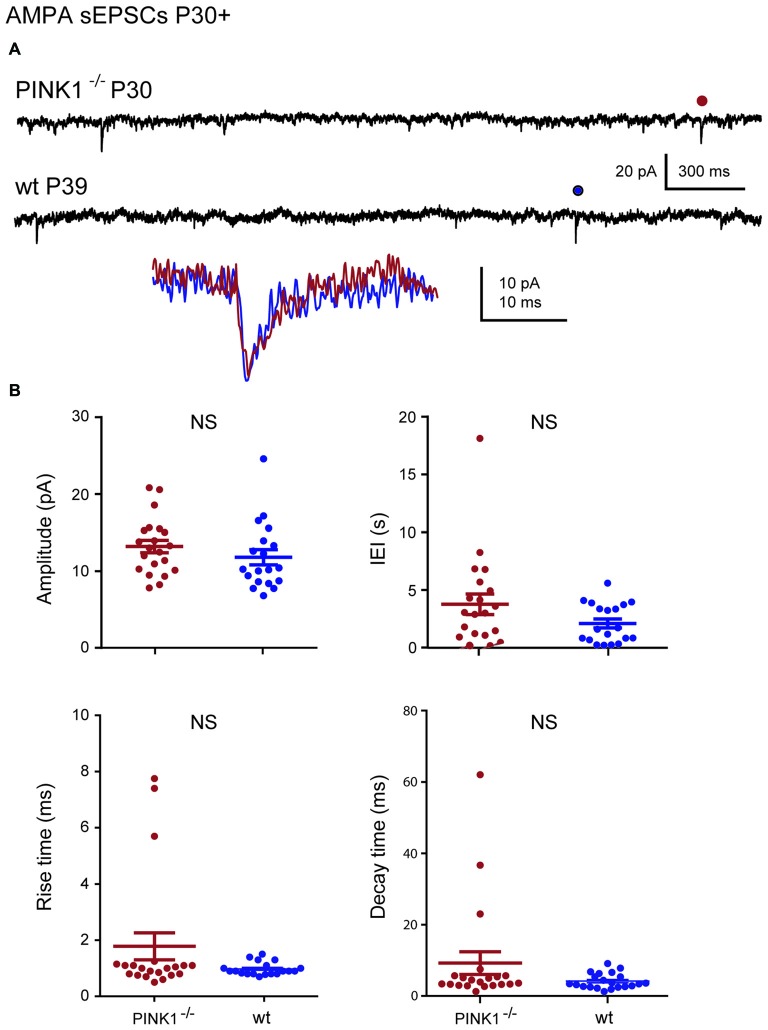
AMPA sEPSCs in young adult (P30+) pink1−/− SNc DA neurons and comparison with age-matched wt SNc DA neurons. (A) Voltage-clamp recordings of AMPA sEPSCs from a P30 pink1−/− (red) and a P39 wt (blue) SNc DA neuron in the continuous presence of gabazine (5 μM) and APV (40 μM) at VH = −60 mV. AMPA events indicated by a dot are enlarged and superimposed in the inset. (B) Quantification and statistical comparison of the amplitudes and IEIs and of the rise and decay times of P30+ pink1−/− (n = 21) and wt (n = 19) AMPA sEPSCs, as indicated.